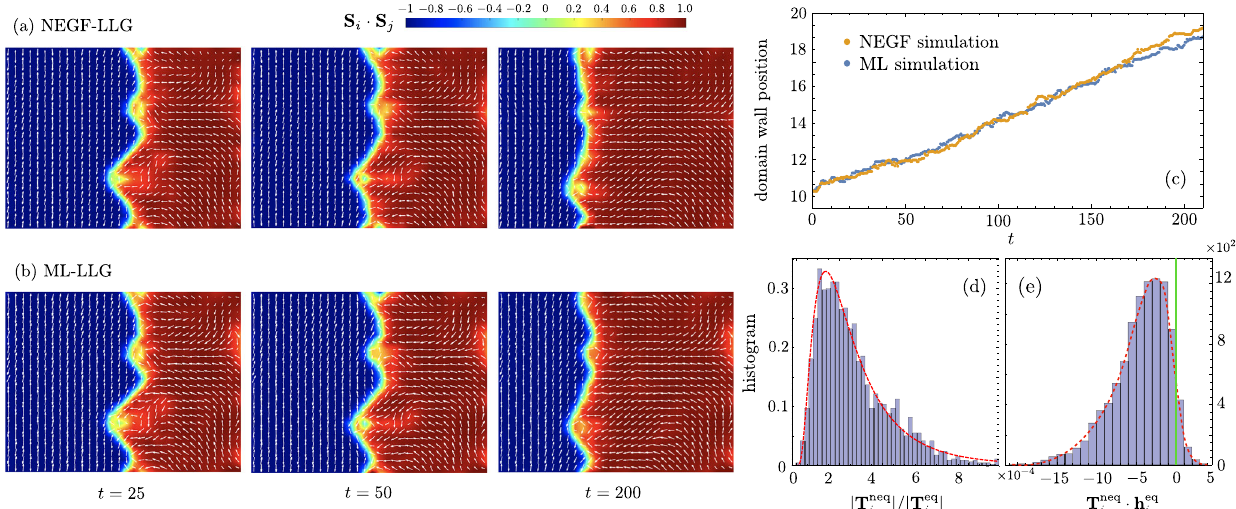
Fig. 4 Benchmark and analysis of ML-LLG simulations of a driven itinerant magnet. a and b Domain wall propagation in a s-d system driven by an external voltage eV = 3.2 t nn . Comparison between ( a ) NEGF-LLG simulations and ( b ) ML-LLG simulations. The lattice size is 30 × 24. The color bar indicates the local nearest-neighbor spin correlation b ij = S i ⋅ S j . Blue (red) area corresponds to AFM (FM) domains. The NEGF-LLG simulation was carried out at a low temperature of k B T = 0.01 t nn , while the ML simulation was performed without Langevin noise. c Average position of FM-AFM domain, obtained from NEGF-LLG and ML-LLG simulations, as a function of time during the voltage-driven insulator to metal transition of the s-d model. d histogram of the ratio j T neq j = j T eq j predicted by the NN model for the simulation of domain- i i wall propagation. The dashed lines are guide for eye. Here T eq ¼ S i ´ ∂ E = ∂ S i is the quasi-equilibrium torque, and T neq i